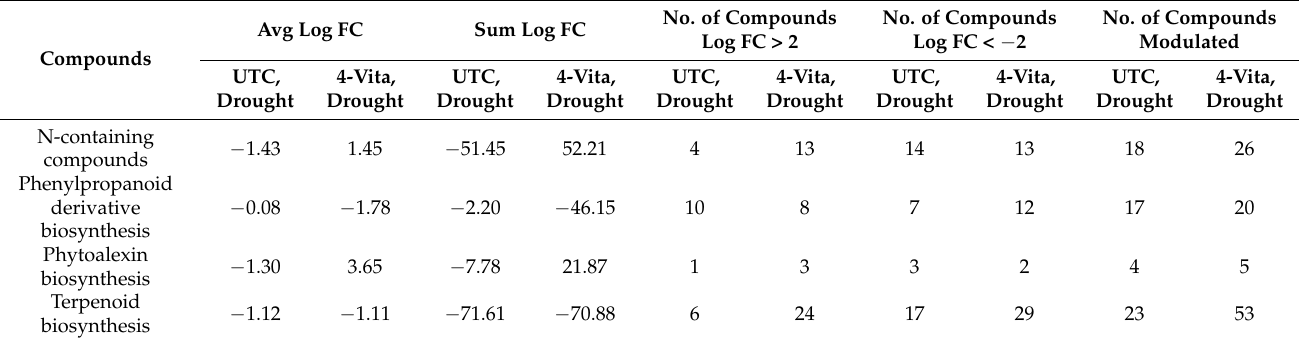
Table 8. N-containing compounds, phytoalexins, phenylpropanoids, and terpenoids modulated by 4-Vita in tomato plants under drought stress conditions, compared to untreated control